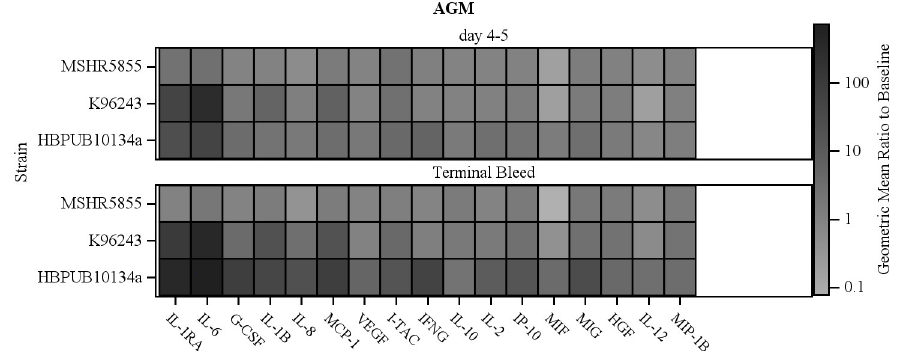
Fig 6. Comparison of increases in cytokine and chemokine levels in AGMs aerosolized with B . pseudomallei HBPUB10134a, K96243 and MSHR5855. The color scale reflects the geometric mean of the fold increase in serum concentration relative to pre-exposure levels. The increase in these important mediators was generally greater in the more virulent HBPBUB10134a and K96243 strains when compared to